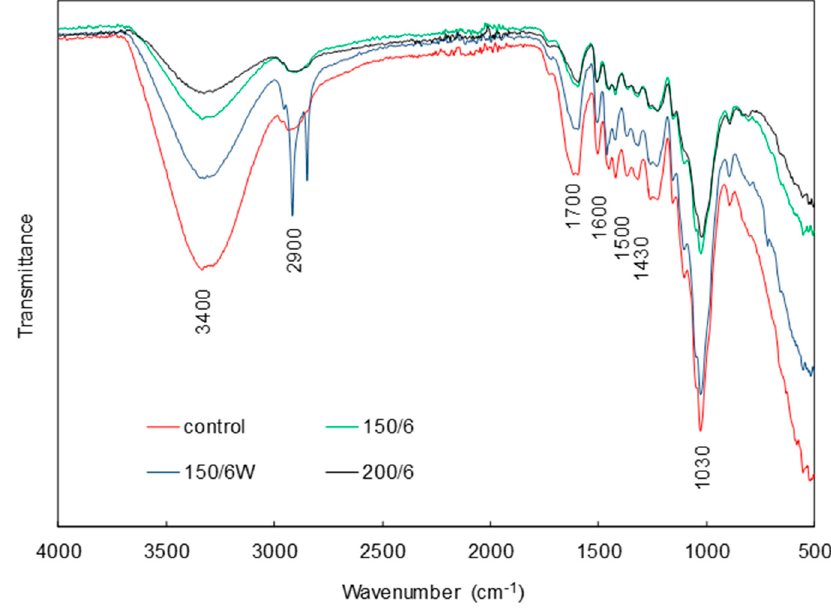
Figure 5. FTIR spectra of control and modified samples.